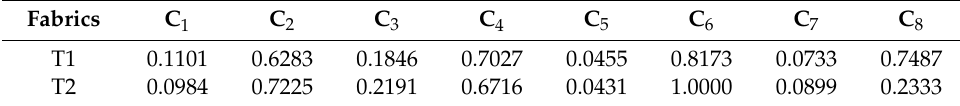
Table 4. Delany and Bazley coe ffi cients of fabrics T1 and